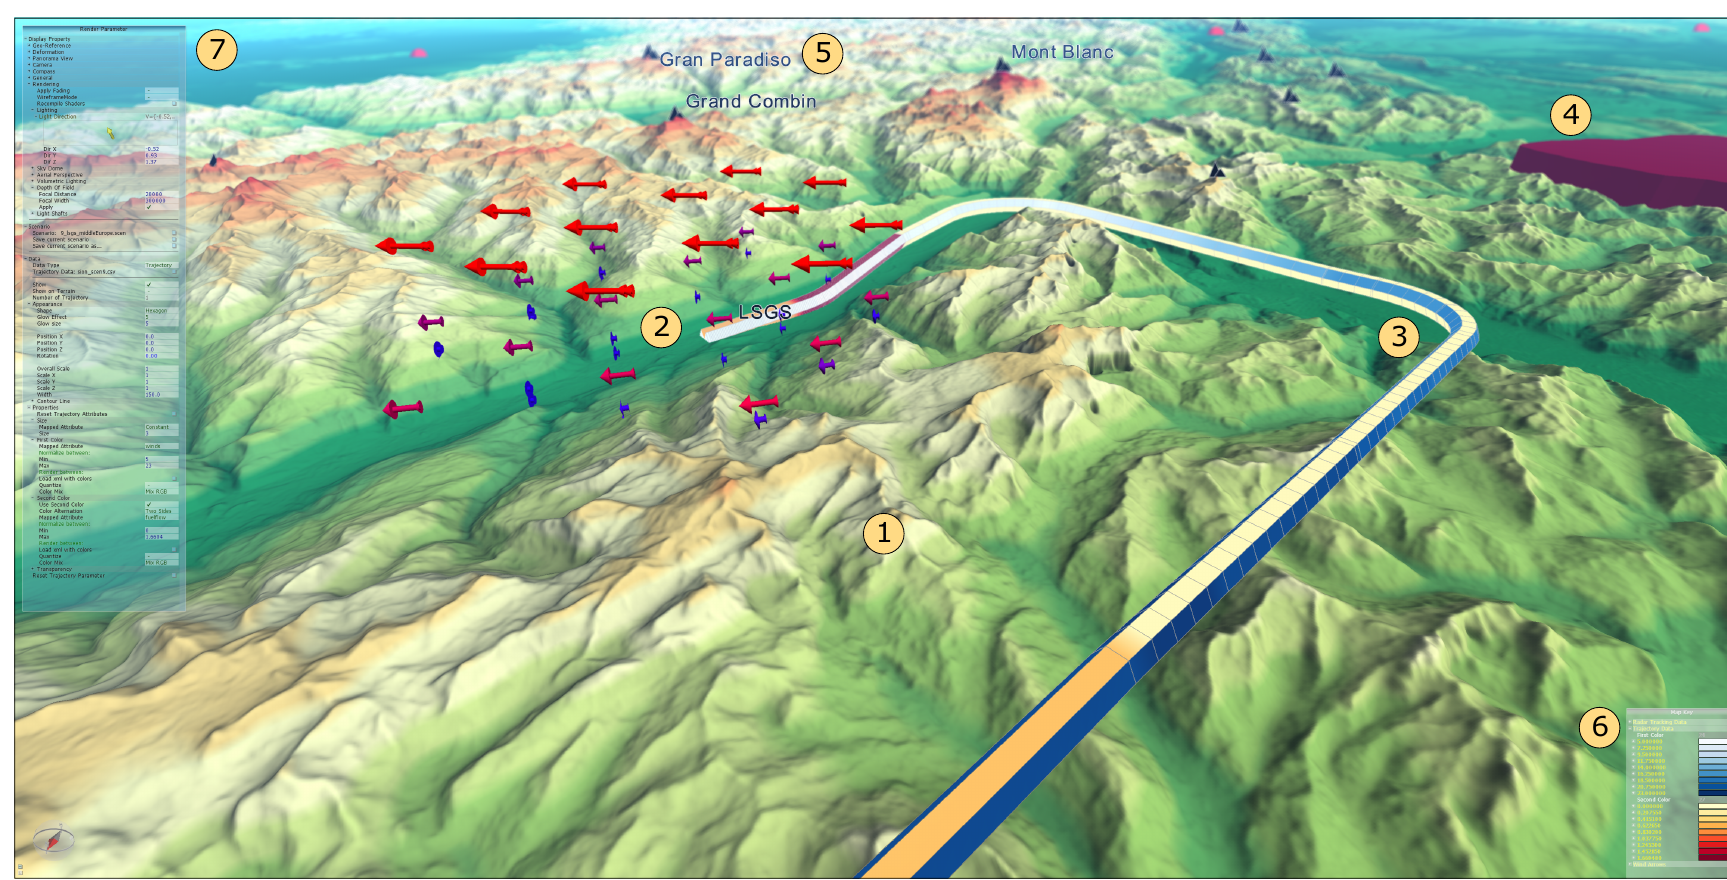
Figure 14. Overview screenshot of T EDA V IS that shows an elevation-colored terrain model of Central Europe 1 (cid:13) , embedded wind data around the Sion airport 2 (cid:13) , an approach trajectory of an aircraft 3 (cid:13) , no-go-areas 4 (cid:13) , and labels for points of interest 5 (cid:13) . The applied color scales are specified in a legend shown in the lower right 6 (cid:13) . The visualization can be interactively parameterized using the graphical user interface 7 (cid:13)